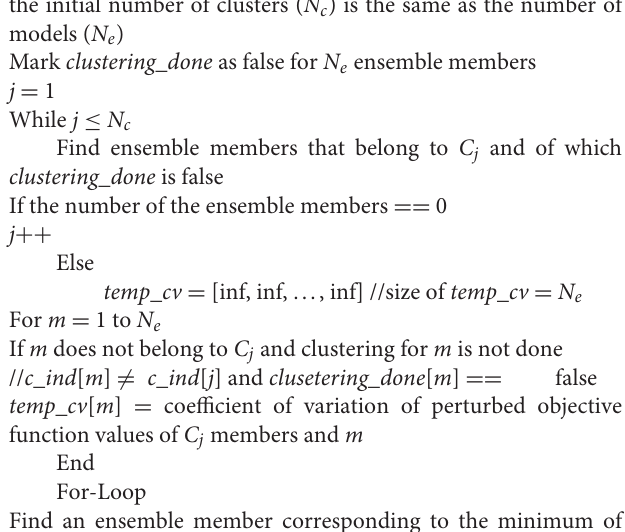
Algorithm 1 : Clustering using a predefined coefficient of variations for HSG ( CV HSG